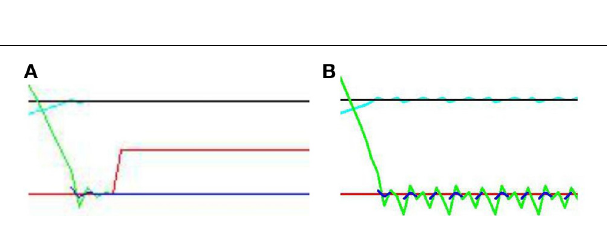
stimulus, but is unable to align precisely with it. This results in the oscillatory aligning movements visible in the gaze direction and auditory signal (green line). As a result of the failure to align precisely, the subject does not go into learning mode. See Figure 10 for a zoomed in view of these oscillations.